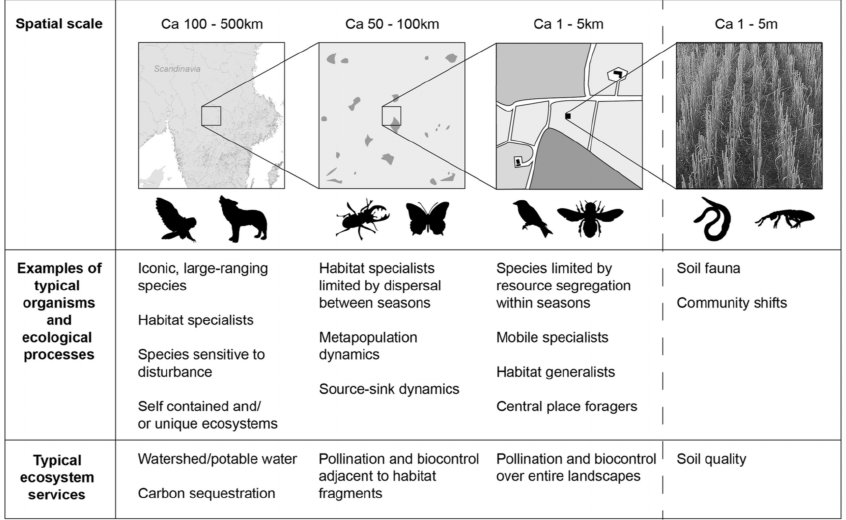
Figure 2. A simplistic representation of spatial scales at which ecological processes modulating biodiversity and multiple ecosystem services operate. Besides soil quality, functional groups involved in food and fibers production mostly benefit from resource patches integrated across landscape mosaics spanning a few kilometers (reproduced from